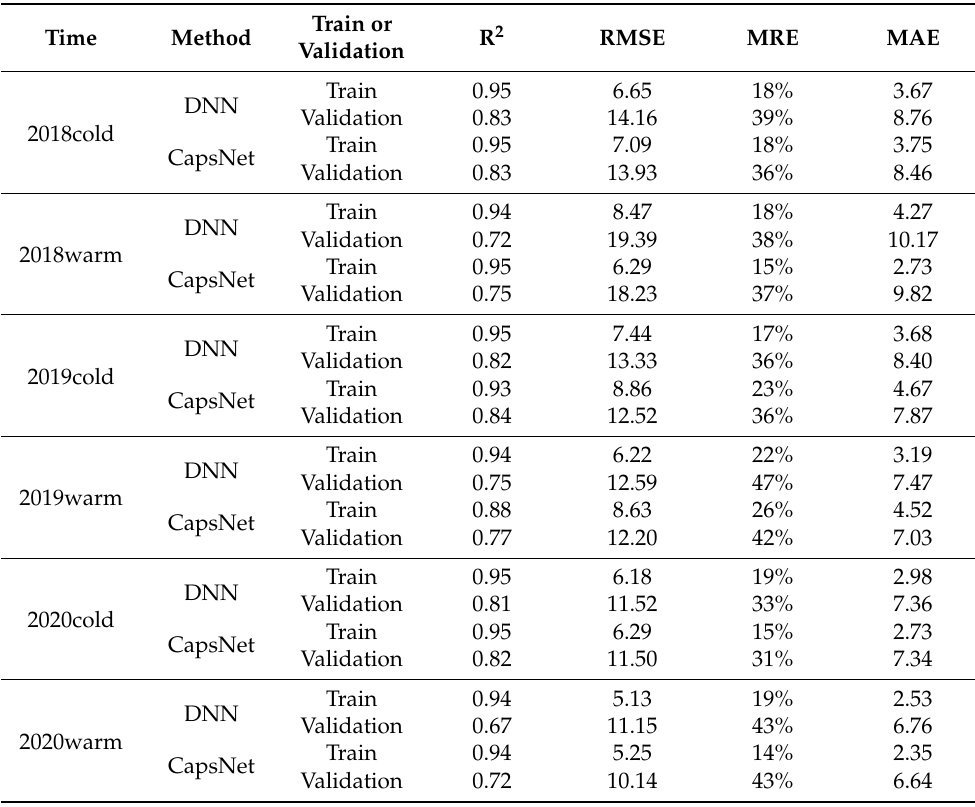
Table 4. The DNN and CapsNet model fitting accuracies in both the cold and warm seasons in